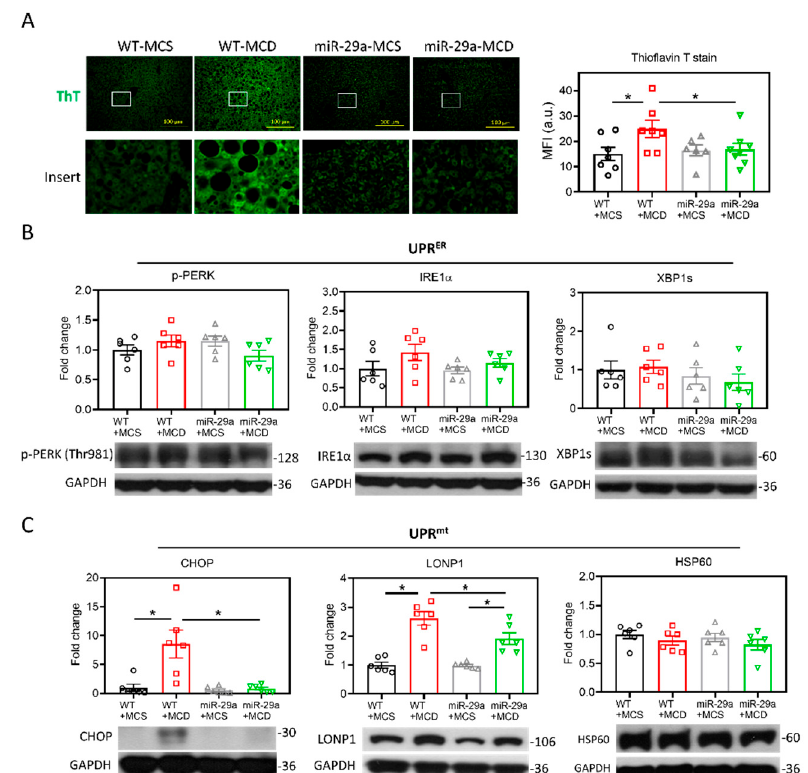
Figure 4. Overexpression of miR-29a alleviated mitochondrial proteostasis stress. ( A ) Misfolded protein aggregation in live tissue was stained by thioflavin T (ThT). White open inserts in the upper panel are enlarged in the lower panel. Scale bar, 100 μ m. Mean fluorescence intensity (MFI) of ThT was determined using Image J. N = 6–8 in each group. a.u., arbitrary unit. ( B ) Representative blots and densitometric results of p-PERK, IRE1 α and XBP1s, indicators of unfolded protein response of the endoplasmic reticulum (UPR ER ). N = 6 in each group. ( C ) Representative blots and densitometric results of CHOP, LONP1, and HSP60, indicators of unfolded protein response of the mitochondria (UPR mt ). N = 6 in each group. Data are expressed as mean ± SE. * p < 0.05 between indicated groups.